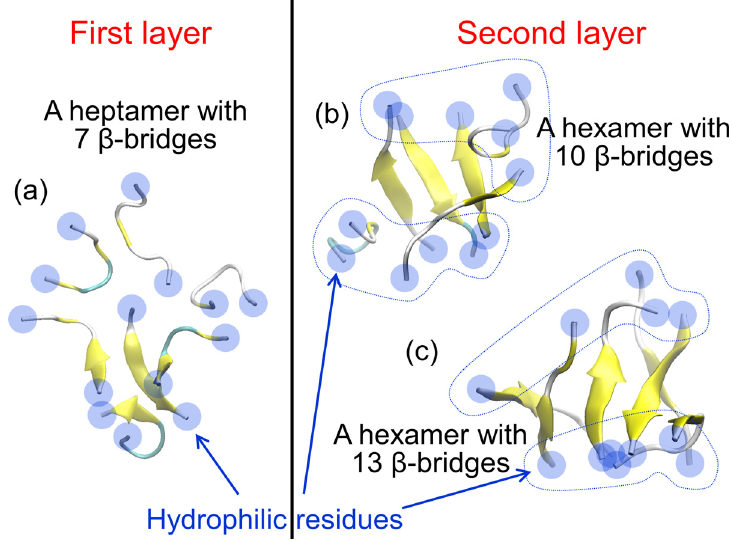
Figure 4. Typical snapshots of A β (16–22) oligomers ( a ) found in the first layer and [( b ) and ( c )] found in the second layer. Reprinted with permission from Reference [45]. Copyright 2020 American Institute of Physics.